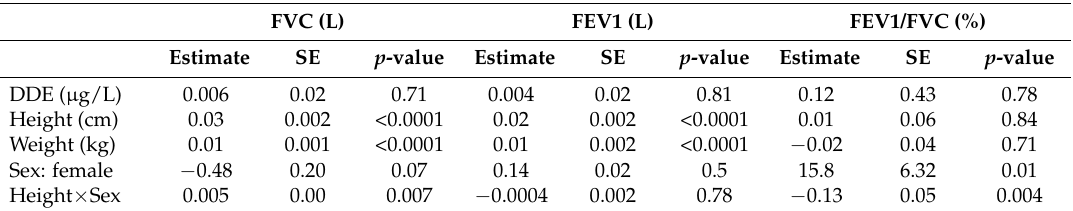
Table 3. Adjusted linear mixed models for pulmonary function, DDE exposure, height, weight, and